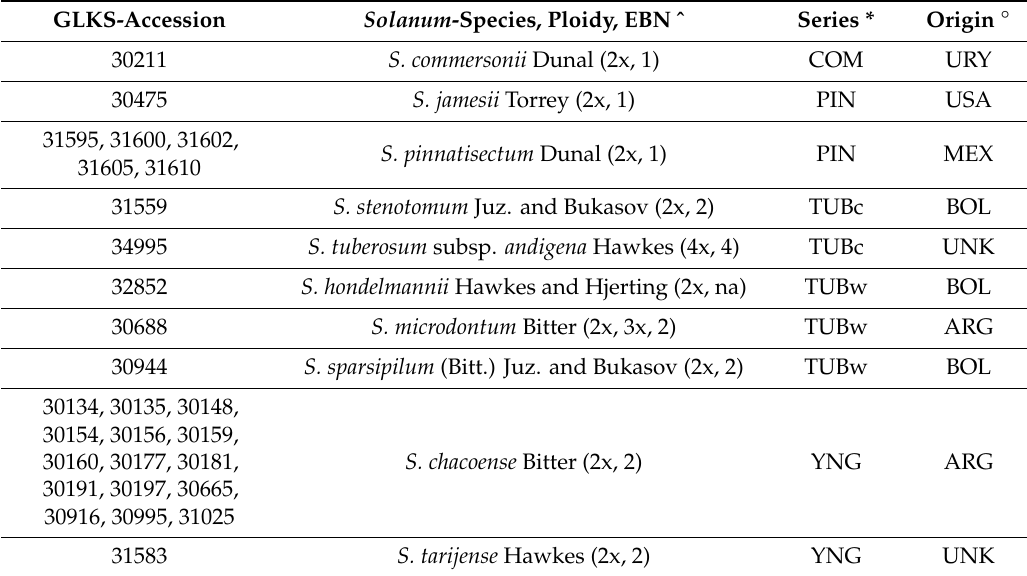
Table 6. Overview of the accessions analyzed for starch content and nitrogen use e ffi ciency as well as passport data of the accessions and taxonomic classification (according to Hawkes